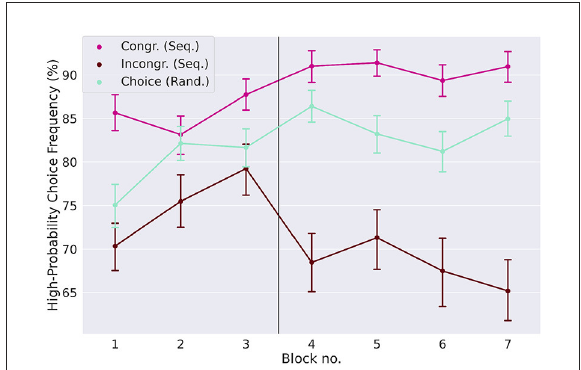
FIGURE3 Influence of implicitly learned sequence on goal-directed action. The high reward-probability (H.P.) choice frequencies (a measure of goal-directed task performance, see Section 2) are shown for the three different types of choice trials: congruent and incongruent trials in the sequential condition, and choice trials in the random condition. In incongruent trials the H.P. choice frequency is lower relative to the random condition, while it is higher in congruent trials. This shows that the preference for a sequential response not only creates a conflict in incongruent trials, but also aids the decision process in congruent trials. The difference between the H.P. choice frequencies for congruent and incongruent trials, which is a measure of the strength of the learned action sequence, increases strongly from day one to day two. Error-bars show standard errors of the